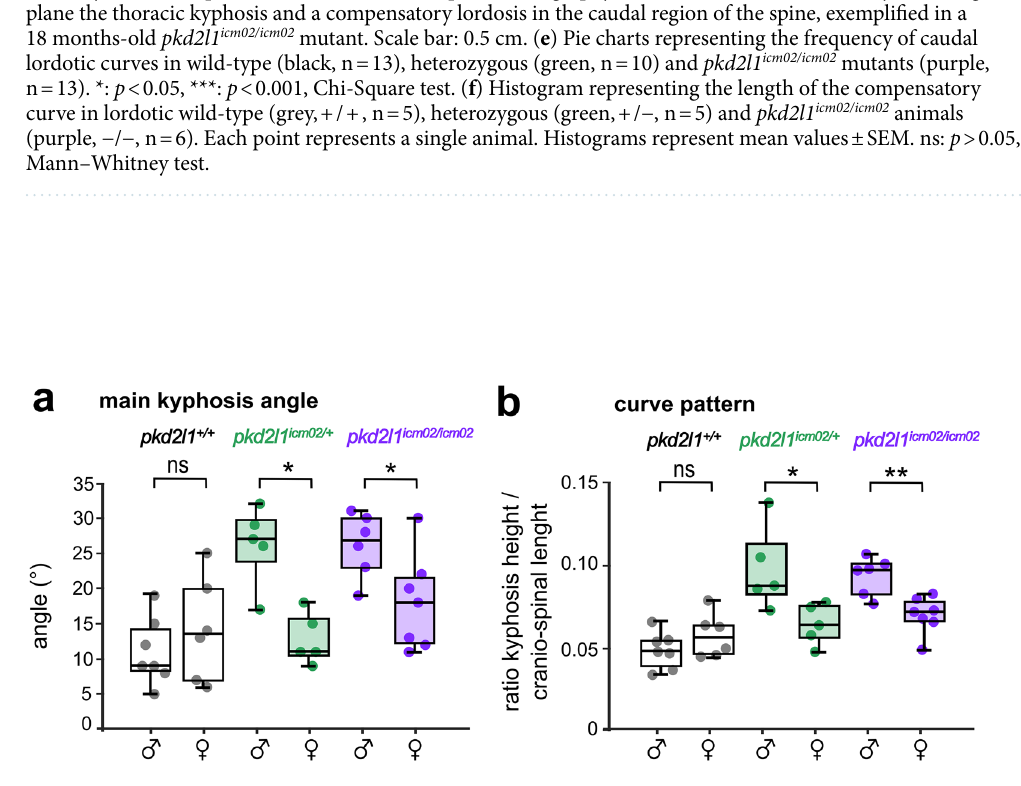
Figure 5. The severity of spine hyper-kyphosis in pkd2l1 mutants is sexually biased towards males. Distribution of the main kyphosis angle ( a ) and the curve pattern ( b ) in 18 months-old males and females of wild-type (black, + / + , n = 7 and 6 males and females respectively), heterozygous (green, + /, n = 5 and 5 males and females respectively) and mutant genotypes (purple, −/−, n = 6 and 7 males and females respectively). Each point represents a single animal. Boxplots represent median values ± IQR. *: p < 0.05, **: p < 0.01, Mann–Whitney